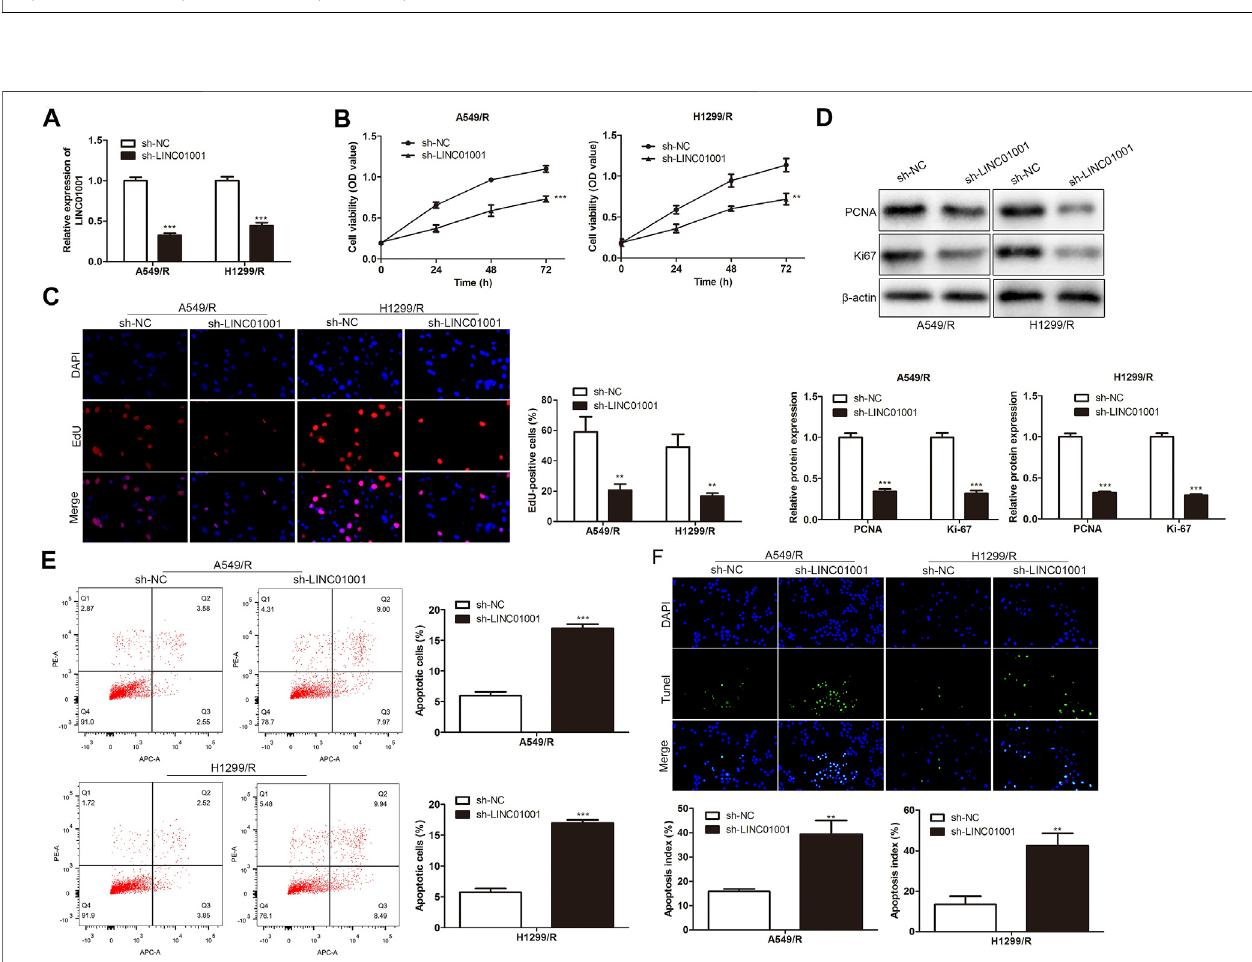
FIGURE 2 | Inhibition of LINC01001 depresses crizotinib-resistance of NSCLC cells. (A) RT-qPCR detected the levels of LINC01001. (B) CCK-8 assay evaluated the viability of crizotinib-resistant NSCLC cells. (C) EdU assay assessed the proliferation of crizotinib-resistant NSCLC cells. (D) Western blot measured the levels of proliferation-related proteins, including PCNA and Ki-67. (E) FACs assessed apoptosis of crizotinib-resistance NSCLC cells. (F) TUNEL staining performed to evaluate apoptosis of crizotinib-resistant NSCLC. ** p < 0.01, *** p < 0.001 vs sh-NC group. Error bars represent SD. Data represent three independent experiments.